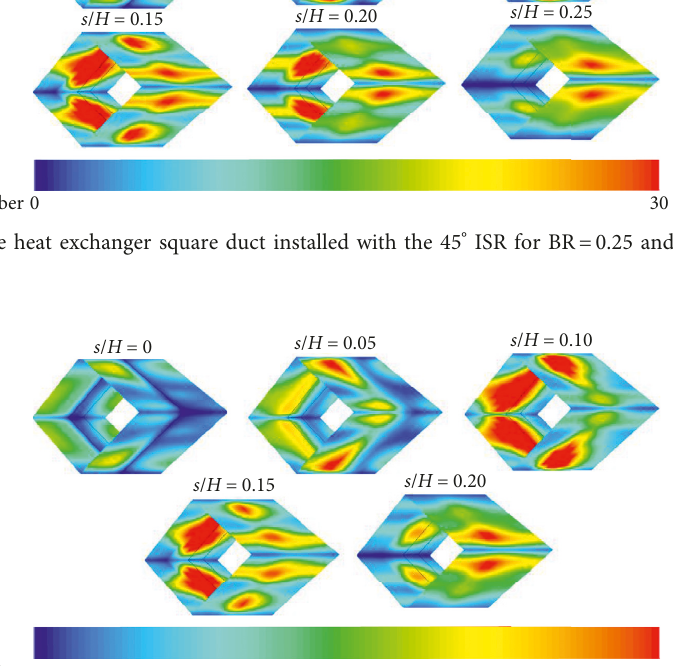
° ISR for BR � 0.30 and Re �